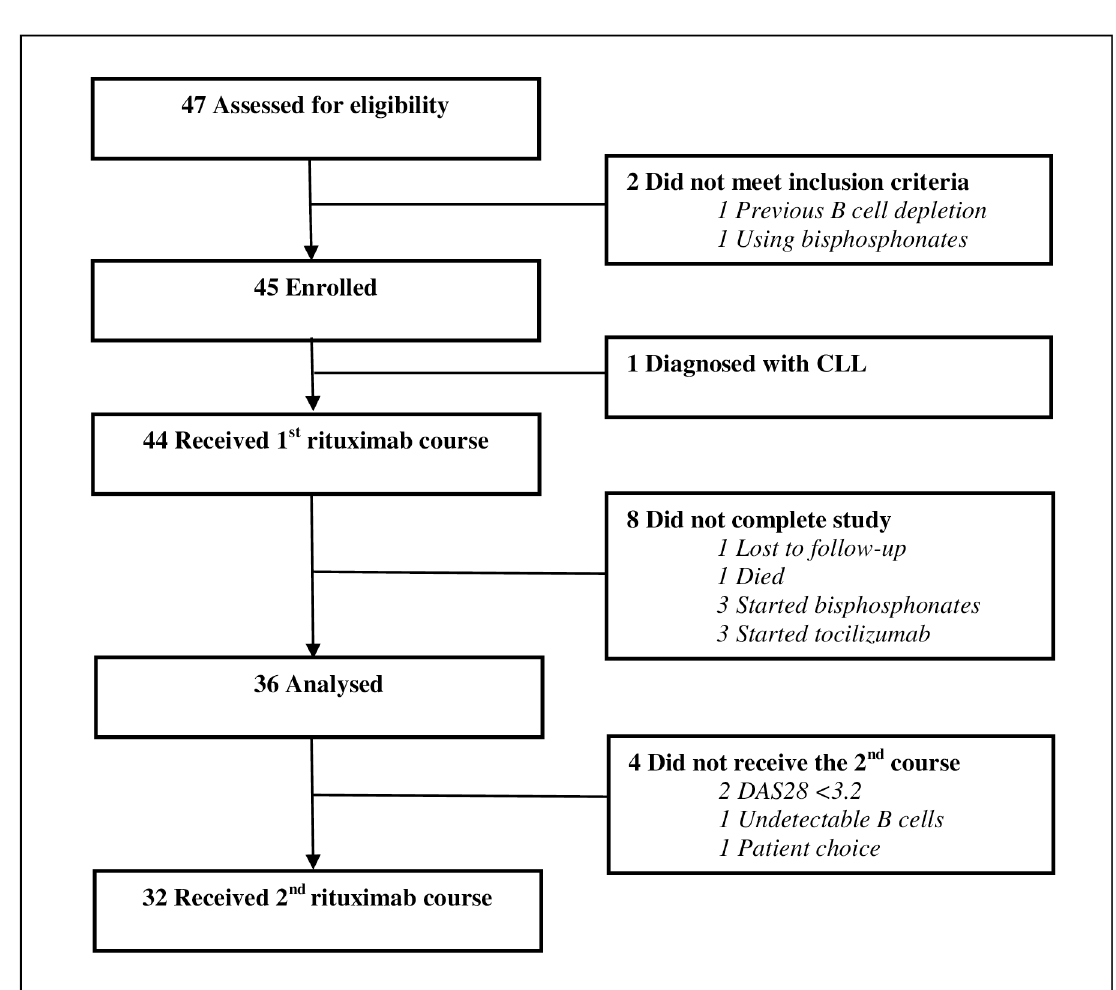
Fig 1. Consort flow diagram. Forty-seven patients were screened; 2 patients did not meet the eligibility criteria and so 45 were enrolled onto the study. One patient was subsequently diagnosed with chronic lymphocytic leukaemia therefore only 44 patients received the first course of rituximab. A further 8 patients did not complete the study and a total of 36 patients were included in the final analysis; of these only 32 received the second RTX course. Sex Hormone Binding Globulin; SJC: Swollen Joint Count; TJC: Tender Joint Count; TRAP5b: tartrate resistant acid phosphatase isoform 5b.